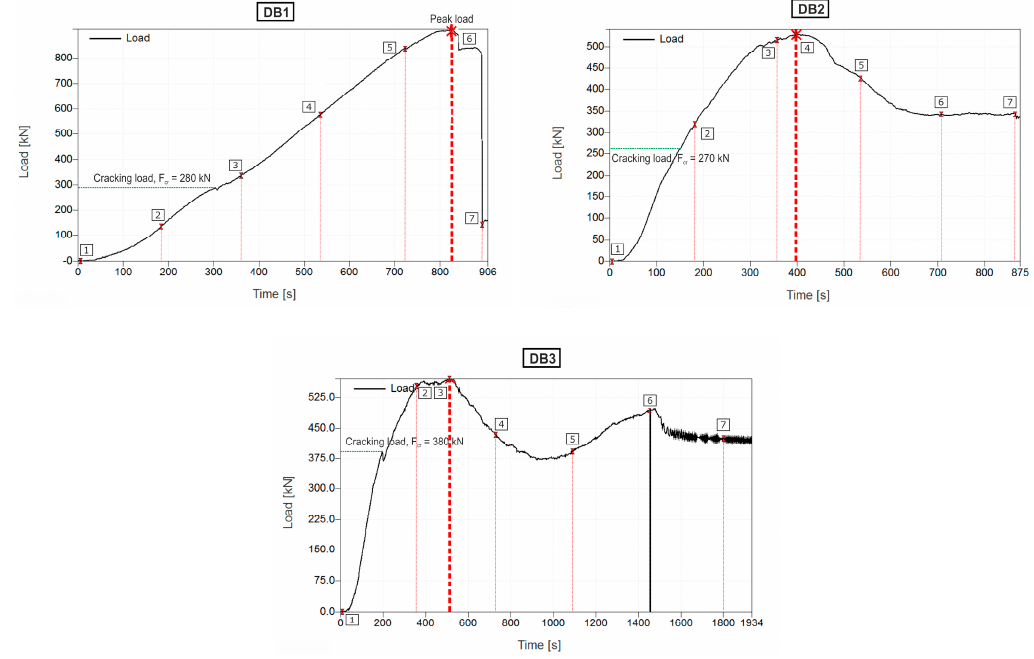
Figure 11. DB load–time curves.